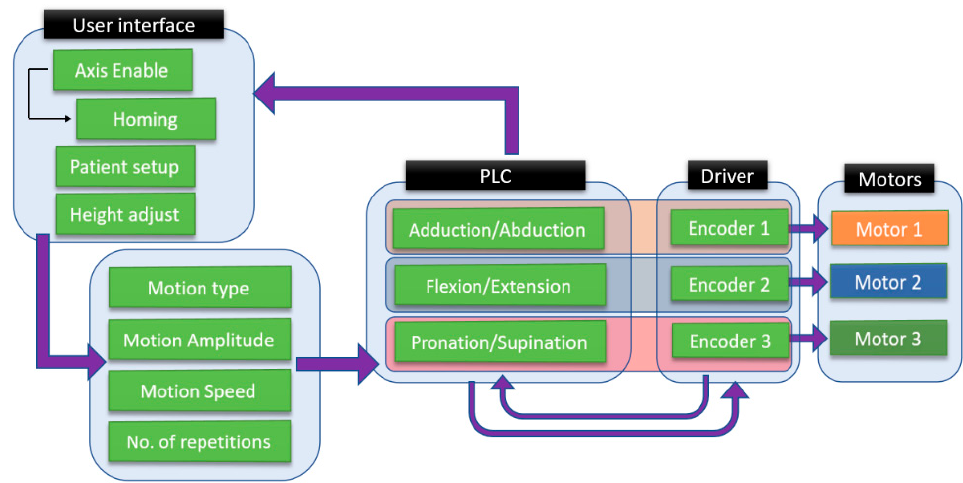
Figure 6. Control strategy of ASPIRE.